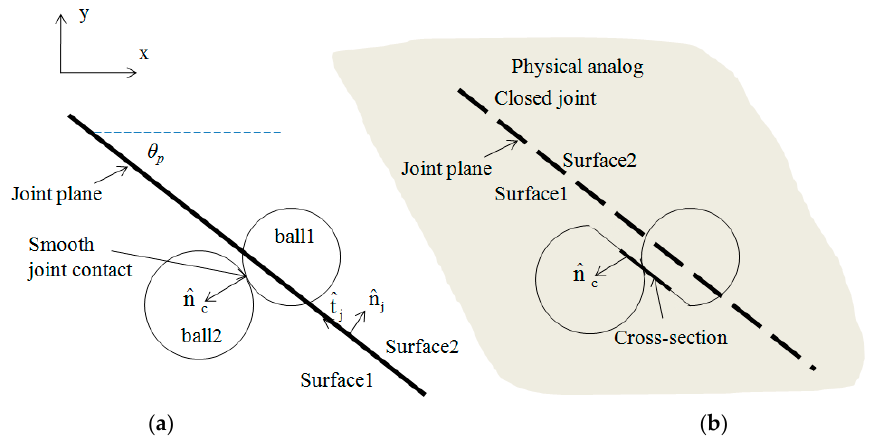
Figure 4. Smooth joint model: ( a ) numerical analog, and ( b ) physical analog.